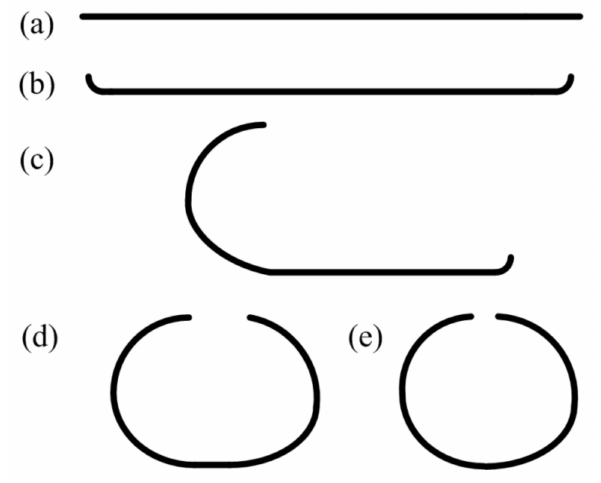
Figure 3. Schematic of JCO pipe forming process: ( a ) initial plate; ( b ) pre-bending; ( c ) J-forming; ( d ) C-forming; ( e )